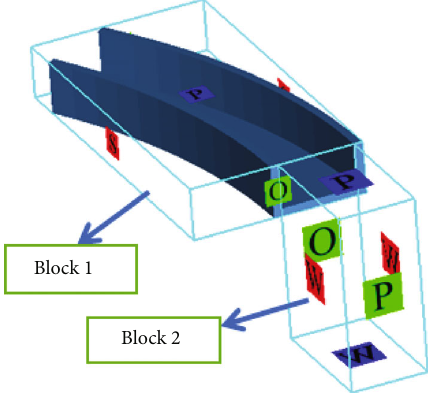
Figure 4: Implementation of the boundary